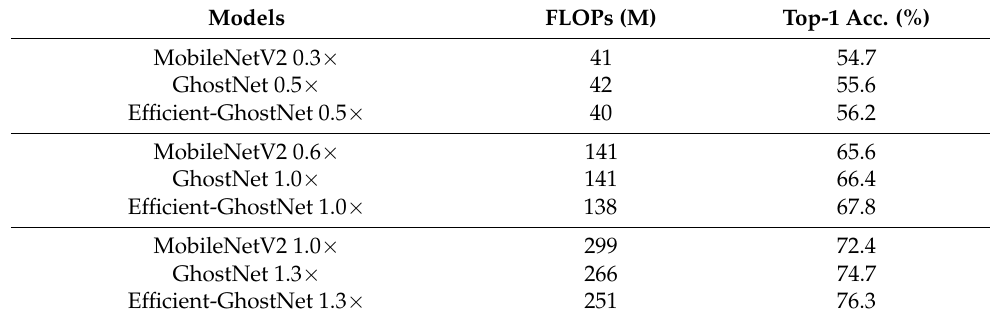
Table 1. Performance comparison of lightweight models under homemade